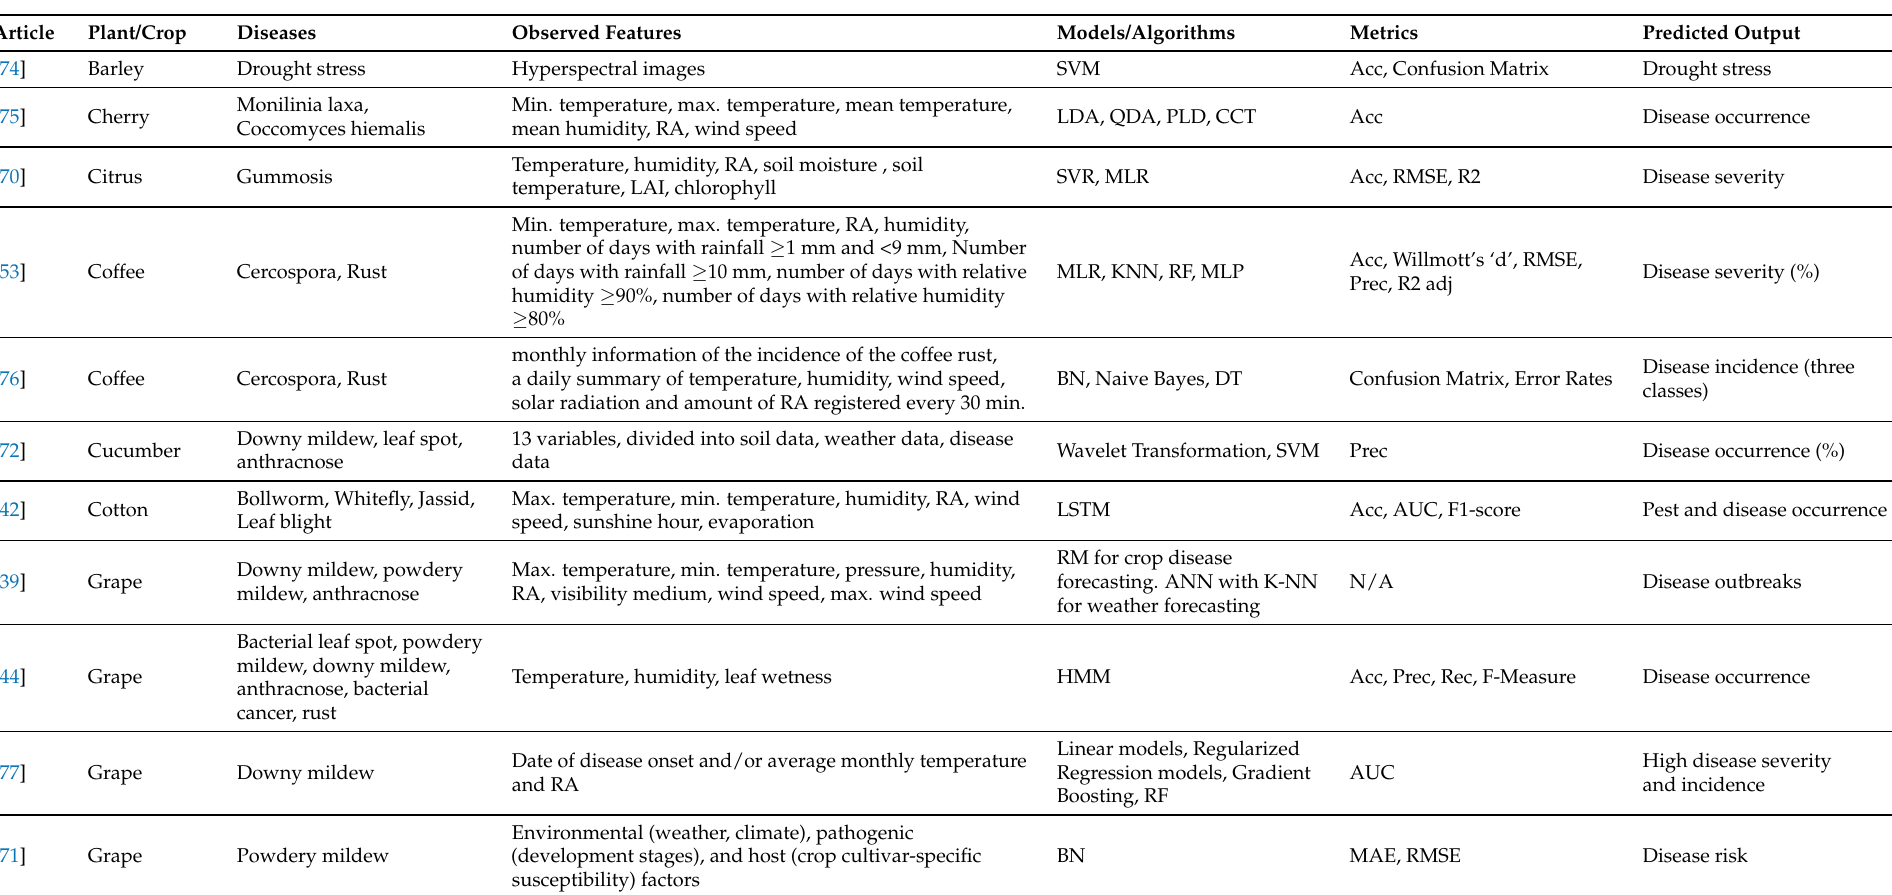
Table 1. Details of articles examined based on the diseases analyzed, techniques adopted, performance metrics used, and predicted output. SVM: Support Vector Machine; RA: rainfall; LAI: Leaf Area Index; LDA: Linear Discriminant Analysis; QDA: Quadratic Discriminant Analysis; PLD: Pseudo linear discriminant; CCT: Compact Classification Tree; MLR: Multi-Linear Regression; KNN: K-Nearest Neighbor; RF: Random Forest; MLP: Multi-Layer Perceptron; BN: Bayesian Network; DT: Decision-Tree; LSTM: Long Short-Term Memory; RM: Regression Model; RBF: Radial Basis Function; LVQ: Learning Vector Quantization; AUC: Area Under the Curve; HMM: Hidden Markov Model; MAE: Mean Average Error; RMSE: Root Mean